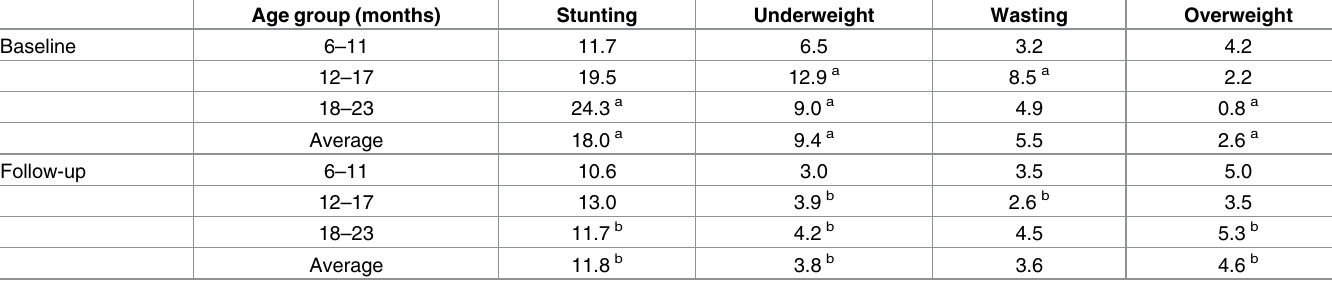
Table 4. Growth status of children in the baseline and follow-up surveysfor different age groups (%).